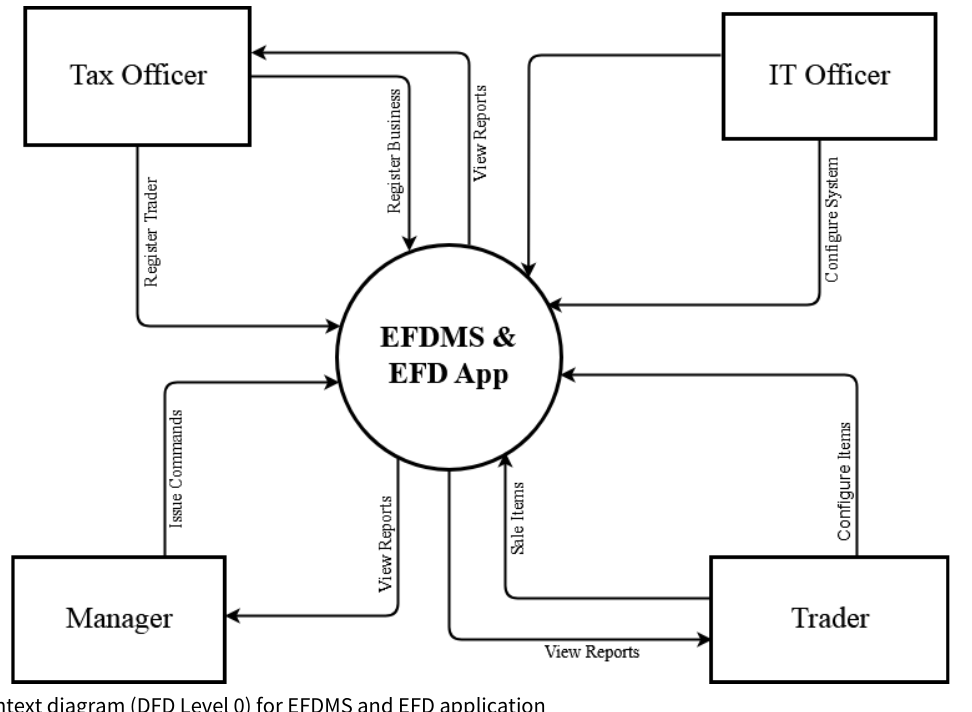
Figure 1. Context diagram (DFD Level 0) for EFDMS and EFD